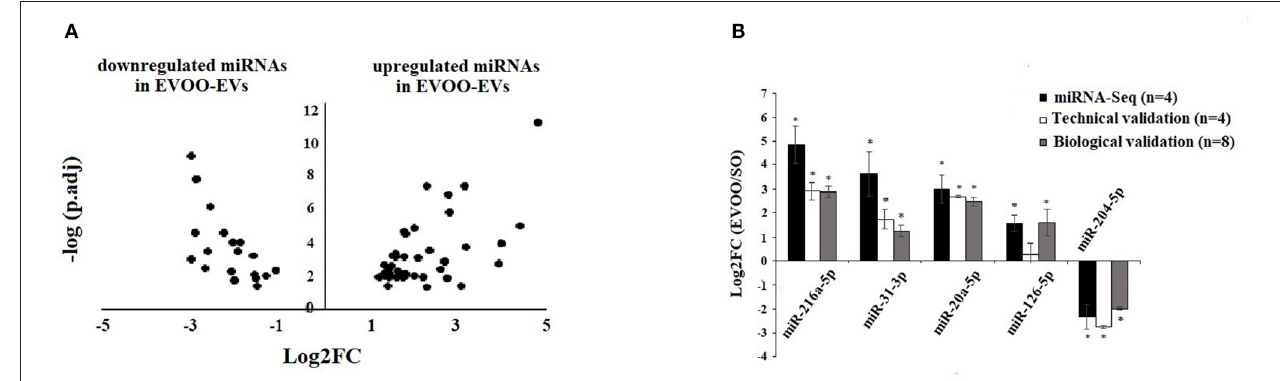
FIGURE 2 | (A) Volcano Plot of the DE-miRNAs in EVs secreted by HUVECs incubated with EVOO-derived TRLs (EVOO-EVs) and SO-derived (SO-EVs) TRLs. Positive Log2FC: upregulated miRNAs in EVOO-EVs. Negative Log2FC: downregulated miRNAs in EVOO-EVs. (B) Technical and biological validation of 4 up and 1 downregulated DE-miRNA obtained in EVOO-EVs vs. SO-EVs. Data from miRNA-Seq (in black) ( n = 4 per group), from technical validation [in the same samples ( n = 4 per group)] (in white), and from biological validation (in the same 4 samples per group plus another 4 samples per group) (in gray). Data are represented as the mean ± SEM. Log2FC: Fold Change in the expression of each gene. * P < 0.05: significant Log2FC in the up/downregulated miRNAs.